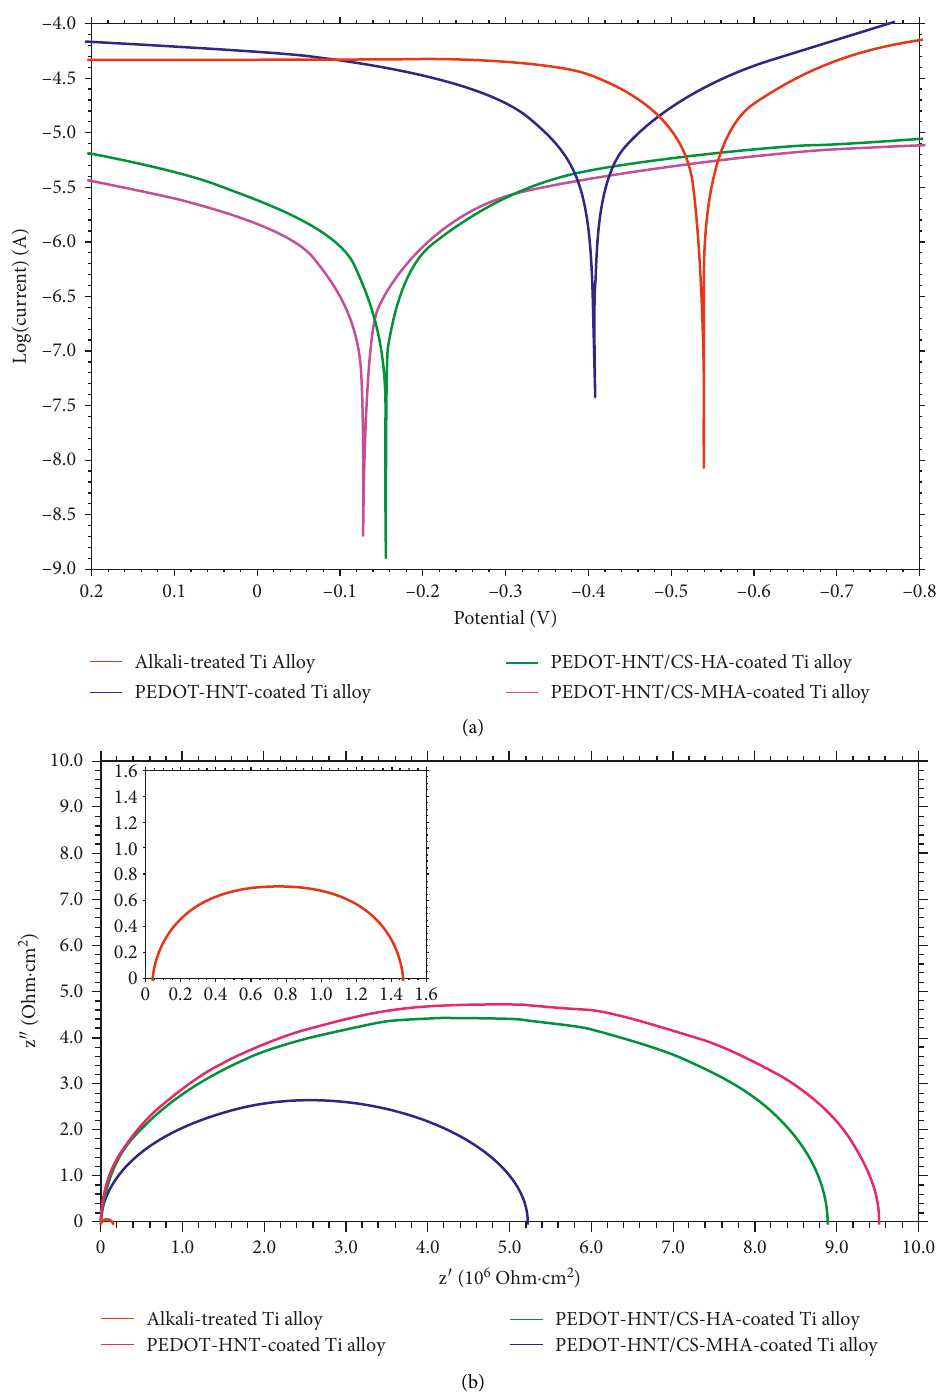
Figure 5: (a) Potentiodynamic polarisation curves of alkali-treated Ti alloy, PEDOT-HNT coated on the Ti alloy, PEDOT-HNT/CS-HA coated on the Ti alloy, and PEDOT-HNT/CS-MHA coated on the Ti alloy in SBF solution. (b) Nyquist plots of alkali-treated Ti alloy, PEDOT-HNT coated on the Ti alloy, PEDOT-HNT/CS-HA coated on the Ti alloy, and PEDOT-HNT/CS-MHA coated on the Ti alloy in SBF